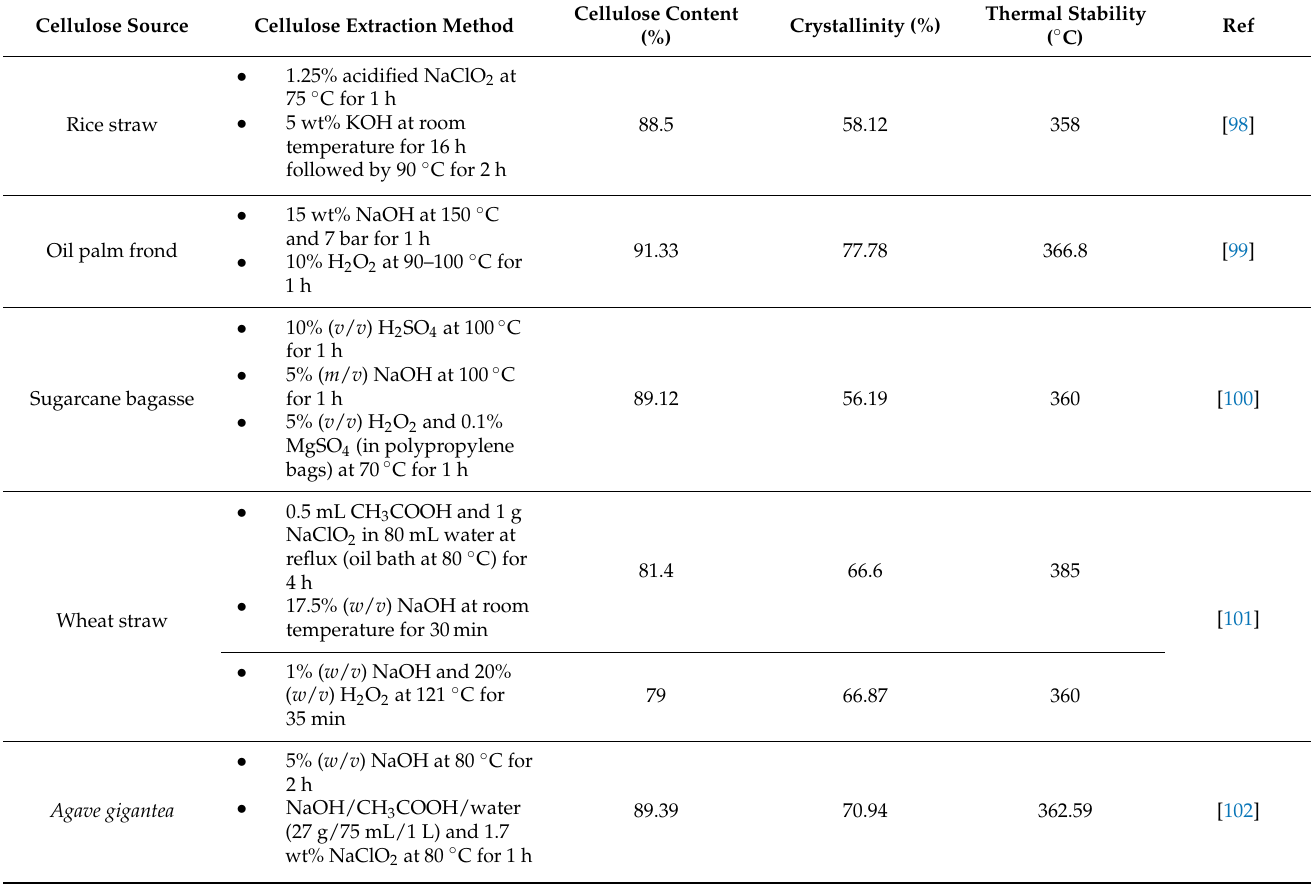
Table 2. Extraction of cellulose from lignocellulosic biomass using different combined treatment